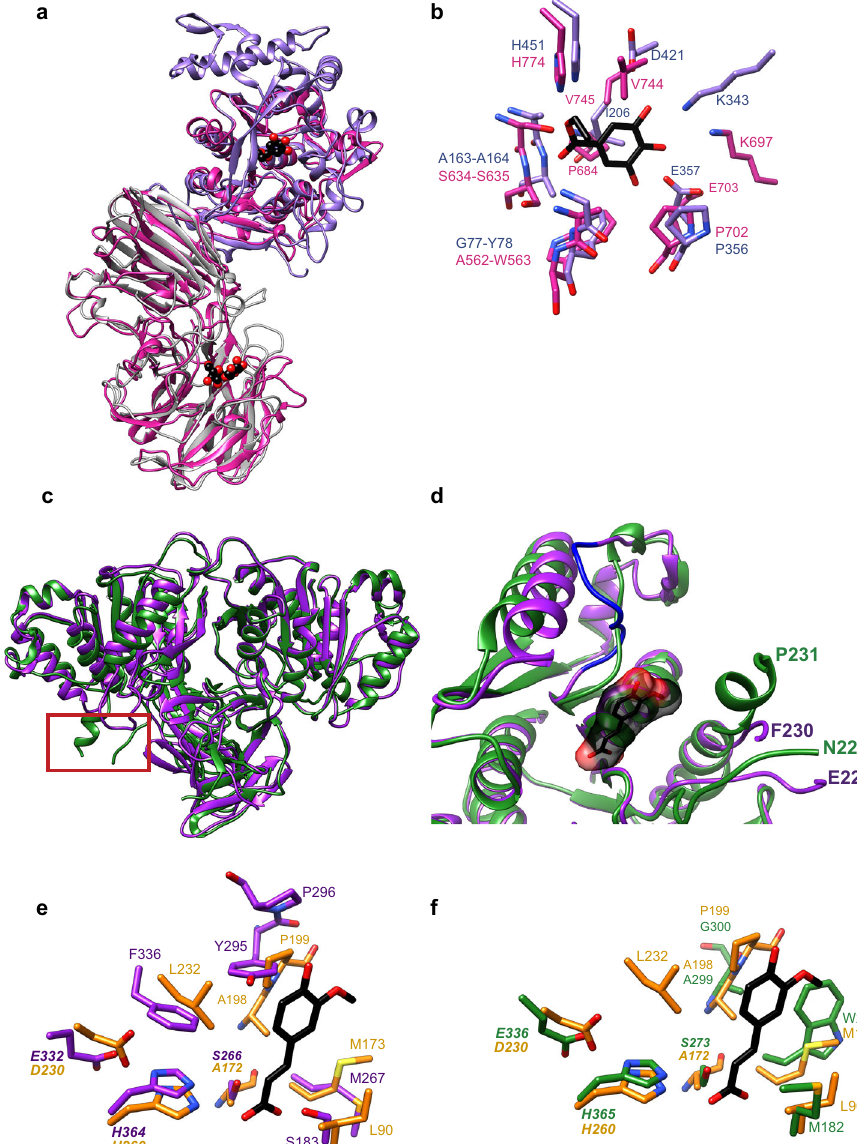
Fig. 5 Molecular structures of Bacteroides spp. esterases. a Molecular structure of the BeGH43/FAE bifunctional enzyme (pink ribbon). At the N- terminus, the structure of the β ,1,4-xylosidase (GH43) from Geobacillus thermoleovorans (gray, PDB 5z5i, RMSD = 2.1 Å for 454 residues) has been overlayed, and at the C-terminus the Lactobacillus plantarum tannase (purple, PDB 4jui, RMSD = 2.0 Å for 243 residues) has been overlayed with (FAE) of BeGH43/FAE. Ligands for the 5z5i and 4jui structures are shown in spheres to label the active sites. b Close-up view of the overlay of the active site of the L. plantarum tannase (purple, PDB 4jui) with the C-terminal ferulic acid esterase (FAE) domain of BeGH43/FAE. Residues within 4.0 Å of gallic acid in the tannase and structurally homologous in the B. eggerthii enzyme are displayed. c Ribbon diagram overlay of the dimeric structures of Bi1033-CE1 (green) and Bi1039-CE1 (purple). The red boxed area highlights the most signi fi cant structural deviation between the enzymes, comprising residues 221 – 233 in Bi1039- CE1 and 220 – 240 in Bi1033-CE1 which includes a chain break from 227 to 230. d Close-up overlay of the active sites of Bi1033-CE1 (green) and Bi1039-CE1 (purple; chain B which includes a small break as indicated). An overlay of Bi1033-CE1 and Bi1039-CE1 with the cellulosomal xylanase Z C-terminal ferulic acid esterase domain from C. thermocellum (PDB 1jt2) complexed with ferulic acid (black and red) was performed to highlight the active site. The region spanning G291-P300 in blue from Bi1039-CE1 is highlighted as it deviates from Bi1033-CE1 in contributing to the active site. e Close-up view of the putative active site residues in Bi1039-CE1 (purple) and the cellulosomal xylanase Z C-terminal ferulic acid esterase domain from C. thermocellum (yellow, PDD 1jt2) complexed with ferulic acid (black and red). f Close-up view of the putative active site residues in Bi1033-CE1 (green) and the C. thermocellum enzyme with ferulic acid (yellow, black, and